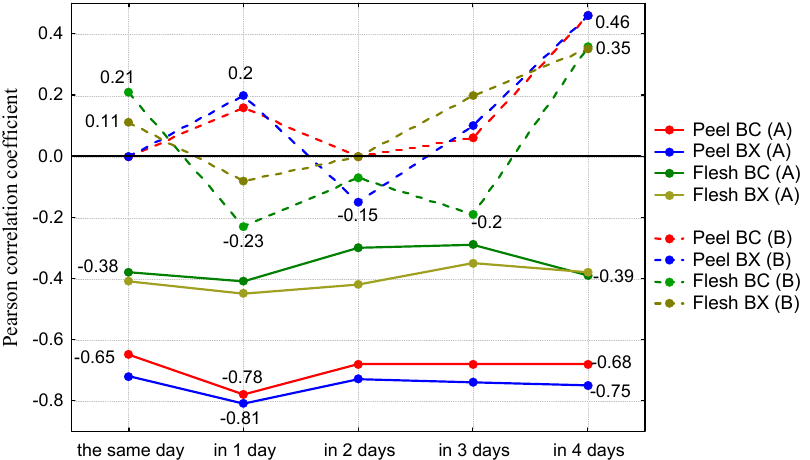
Figure 10. Dynamics of the interplay between betalains in yellow-colored table beet accessions (group 3) and abiotic factors (A—the correlation with air temperature; B—the correlation with rainfall). The period after a rainfall is favorable for the active growth of table beet. Overall, a rather weak or moderate effect of precipitation on the pigment composition was shown for